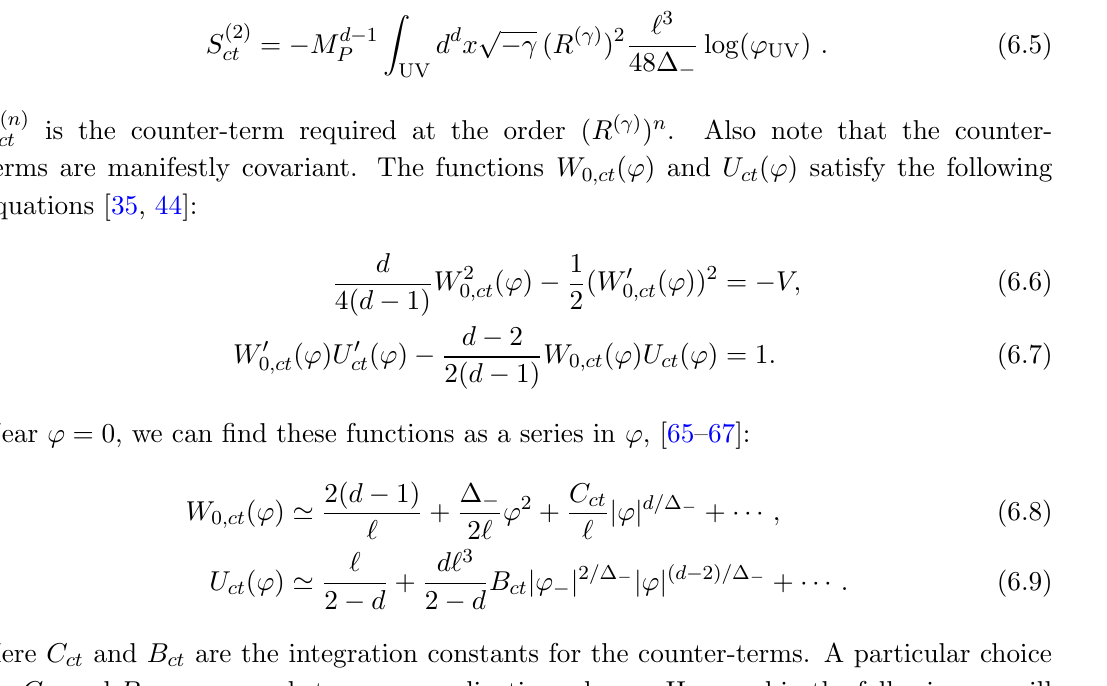
Figure 23. Plot of the degree-12 potential which allows skipping solutions. This potential has several extrema which are denoted as UV 1 , UV 2 , IR 1 and IR 2